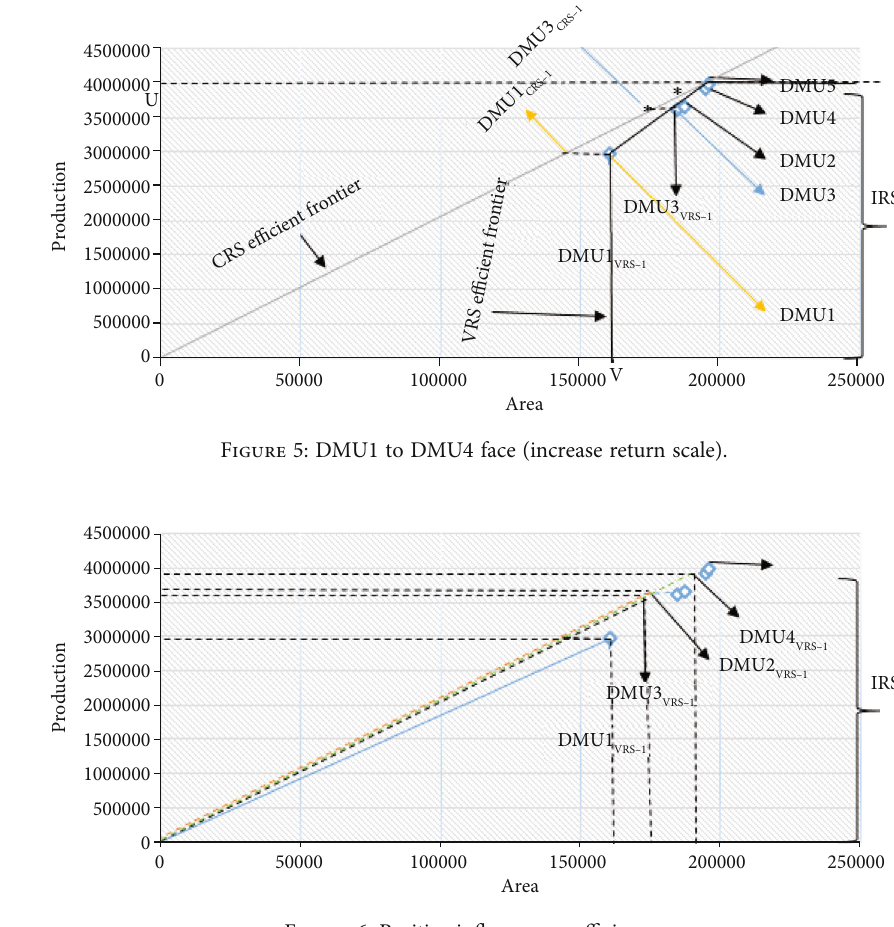
Figure 6: Positive in fl uence on e ffi ciency. Table 4: The statistics and correlation on input/output data of CRS-DEA model (1). Clover area